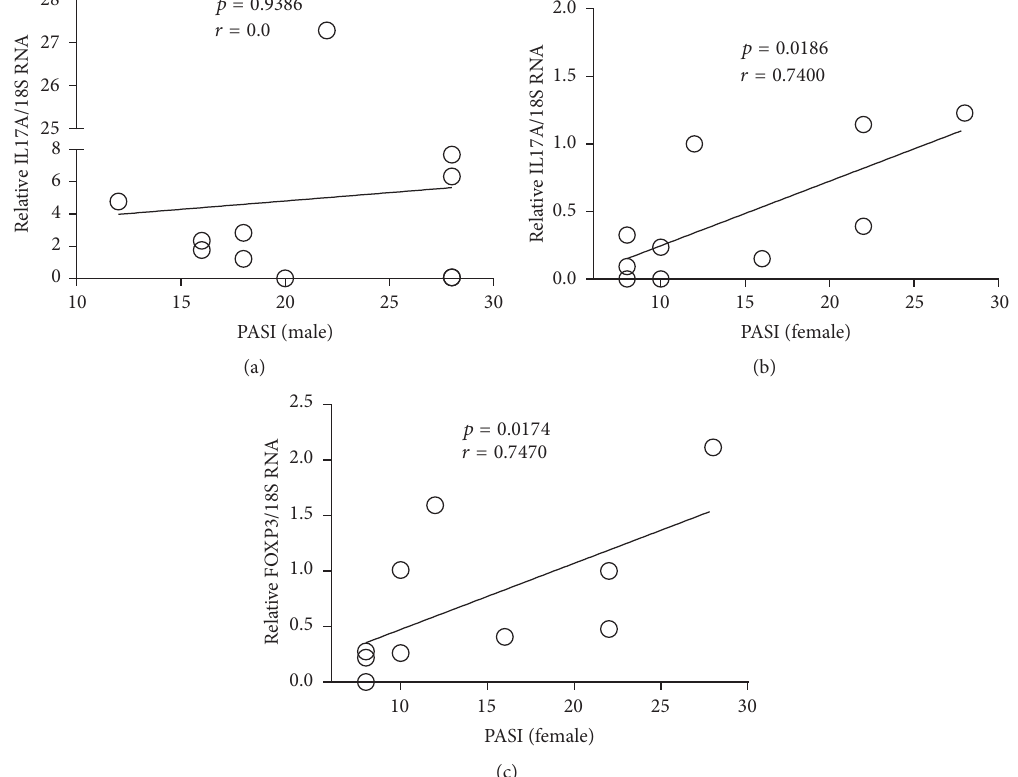
Figure 3: Correlation of IL17A (a, b) and FOXP3 (c) with disease severity between man and